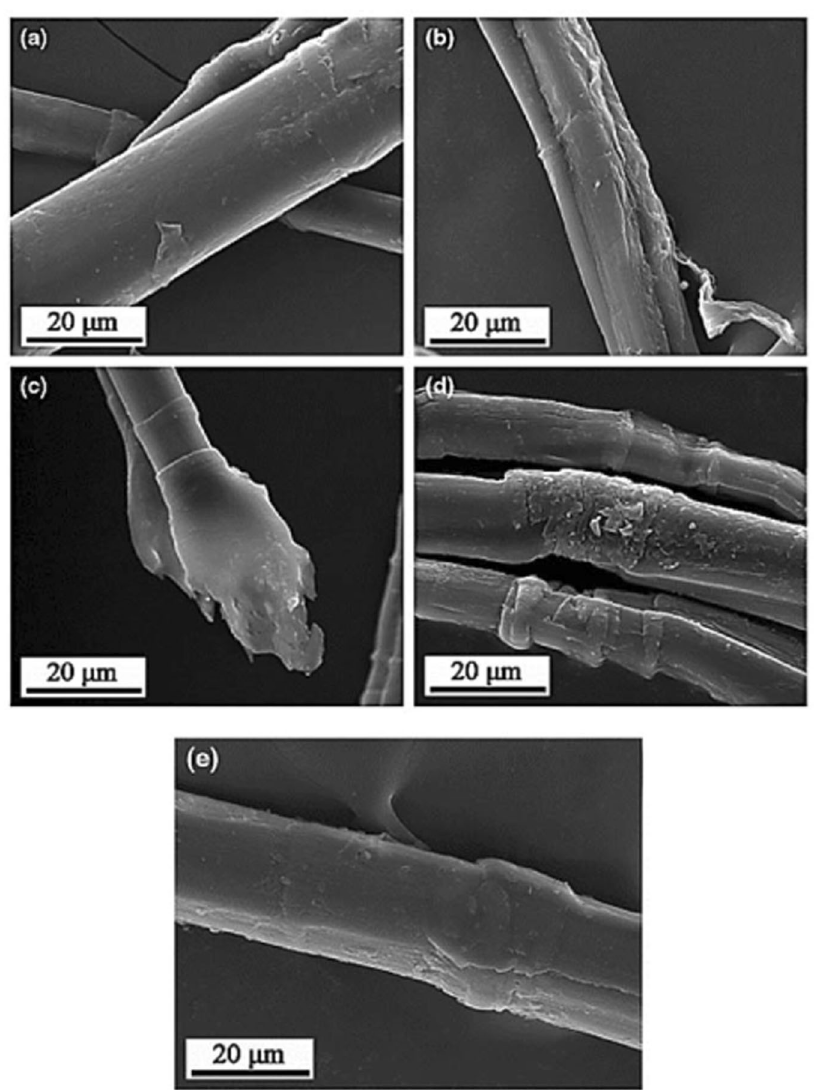
Fig. 13 Morphological changes using various treatment methods. SEM pictures of a untreated fi ber, b alkali-treated fi ber, c coronatreated fi ber, d MA-grafted fi ber, and e silane-treated fi ber 147